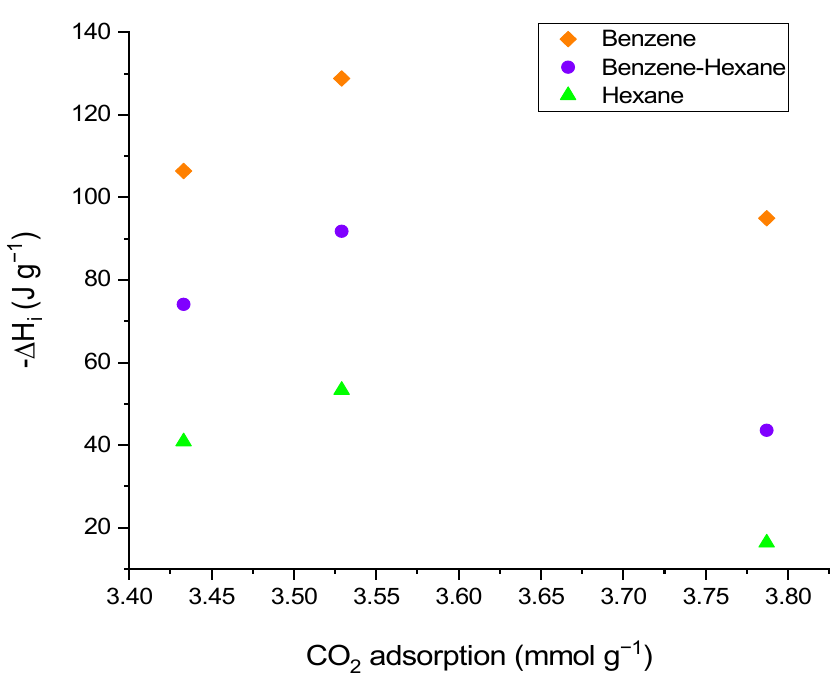
Figure 10. Relationship between the enthalpy of immersion and the amount of adsorbed CO 2 .